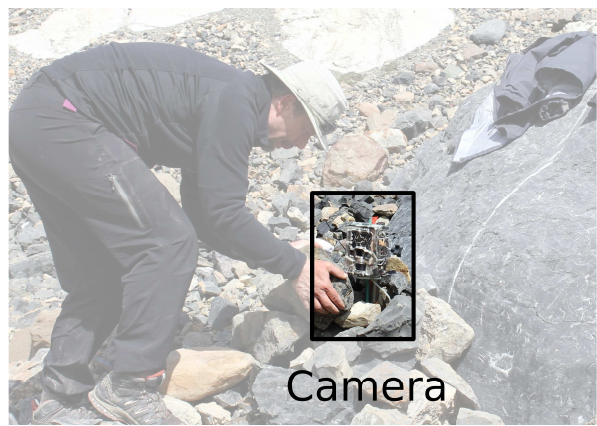
Figure 2. Camera setup. The camera is set on the right bank of the stream, a few metres above the water level. The camera is clamped to a pole hammered into the ground.